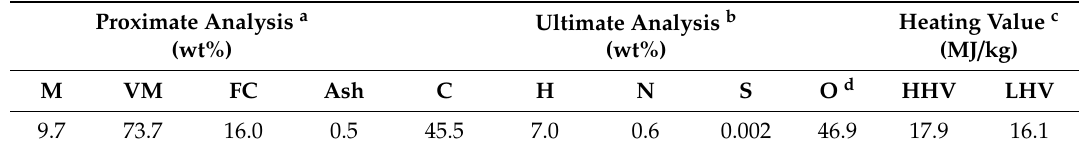
Table 1. Characteristics of wood sawdust